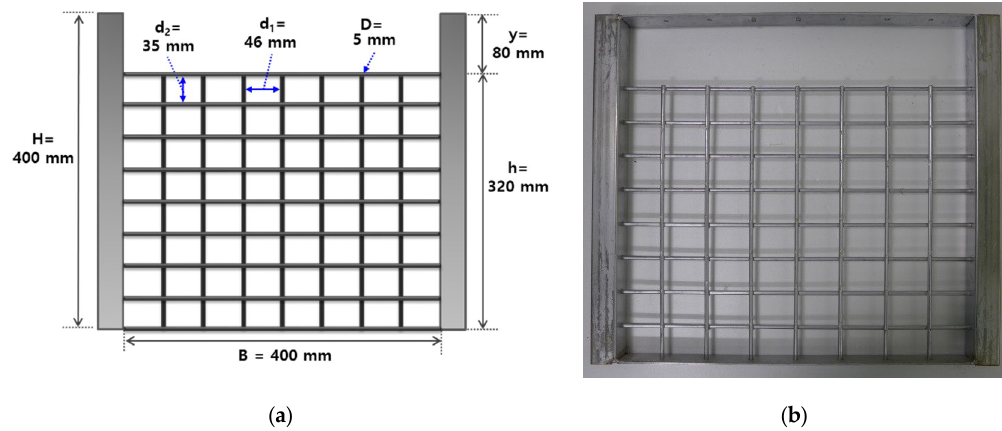
Figure 5. Driftwood capture trellis for agricultural drainage ditches: ( a ) driftwood capture trellis (plan); ( b ) photograph of the implemented driftwood capture trellis.